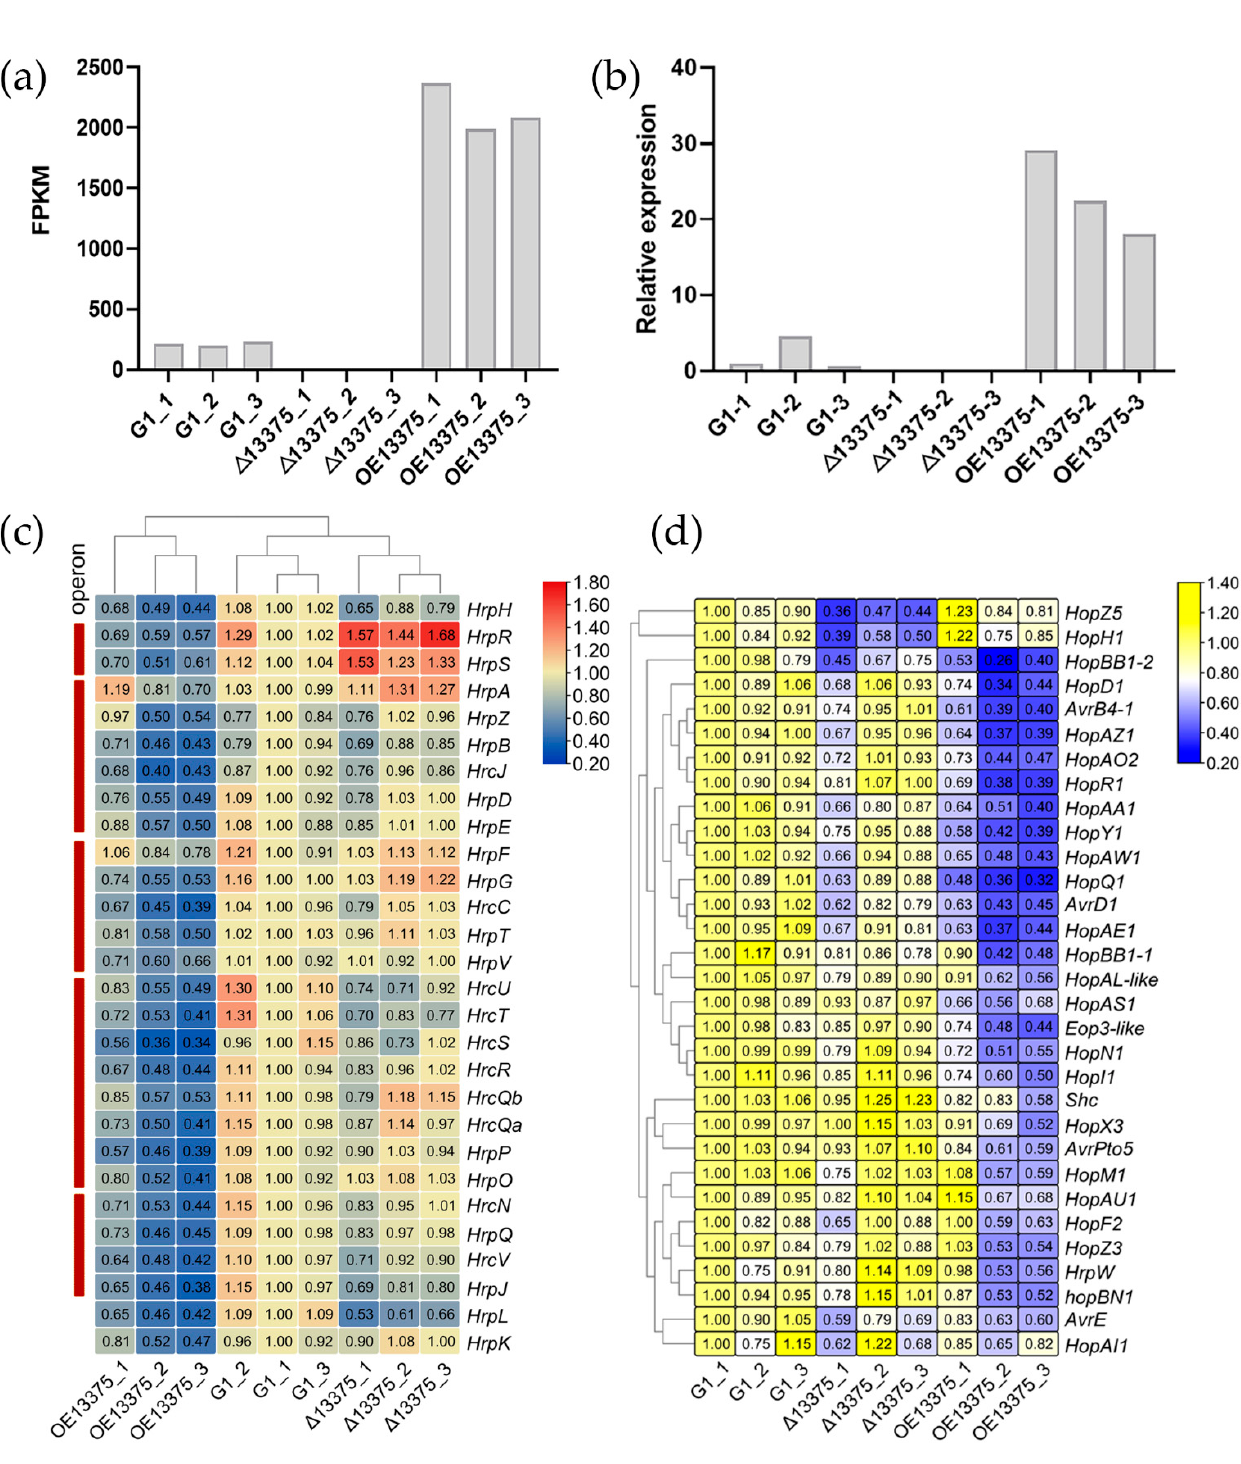
Figure 2. Effects of OmpR-like on type III secretion system-related gene expression. ( a ) The transcription levels of OmpR-like in G1, Δ 13375, and OE13375, based on RNA-seq data. FPKM: fragments per kilobase per million mapped reads; ( b ) The relative expression levels of OmpR-like in G1, Δ 13375, and OE13375 were detected by qRT-PCR.; ( c ) Effects of OmpR-like deletion and overexpression on the transcriptional levels of hrp / hrc genes in G1, Δ 13375, and OE13375; ( d ) Effects of OmpR-like deletion and overexpression on the transcriptional levels of type III effector genes in G1, Δ 13375, and OE13375. G1: wild-type strain; Δ 13375: OmpR-like deletion mutant; OE13375: OmpR-like overexpression mutant.